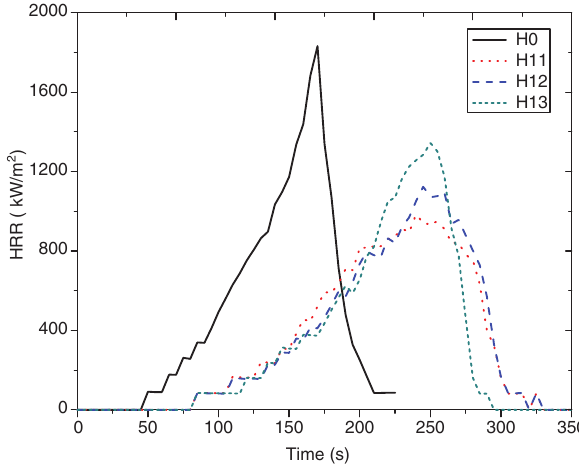
Figure 9: Heat release rate curves of neat PP and the PP/m.Cu-LDH nanocomposites.